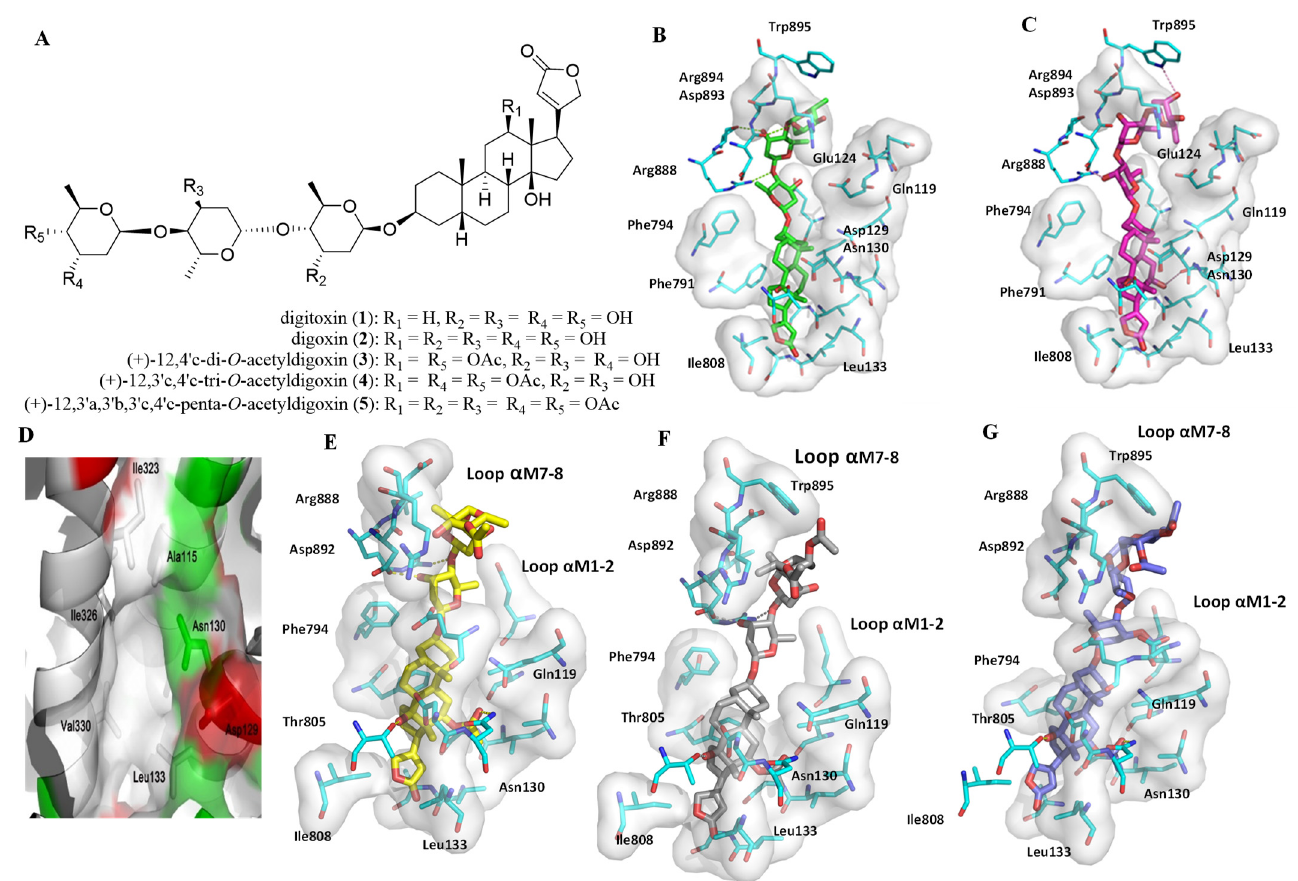
Figure 2. Docking profiles for digitoxin ( 1 ), digoxin ( 2 ), (+)-12,4 ′ c-di- O -acetyldigoxin ( 3 ), (+)-12,3 ′ c,4 ′ c-tri- O -acetyldigoxin ( 4 ), and (+)-12,3 ′ a,3 ′ b,3 ′ c,4 ′ c-penta- O -acetyldigoxin ( 5 ) with NKA. ( A ) Structures of 1 – 5 . ( B , C ) Docking profiles for 1 (green, B ) and 2 (pink, C ) with NKA. ( D ) The Asn130 pocket that C-12 position targeted (white, residues with hydrophobic sidechains; green, residues with polar sidechains; red, residues with negatively charged sidechains). ( E – G ) Docking profiles for 3 (yellow, E ), 4 (gray, F ), or 5 (blue, G ) and NKA. Table 1. Docking score from the binding to NKA (PDB:4RET) and cytotoxicity (IC 50 µM) of digitoxin and digoxin and its derivatives ( 1 – 11 ). Compd.